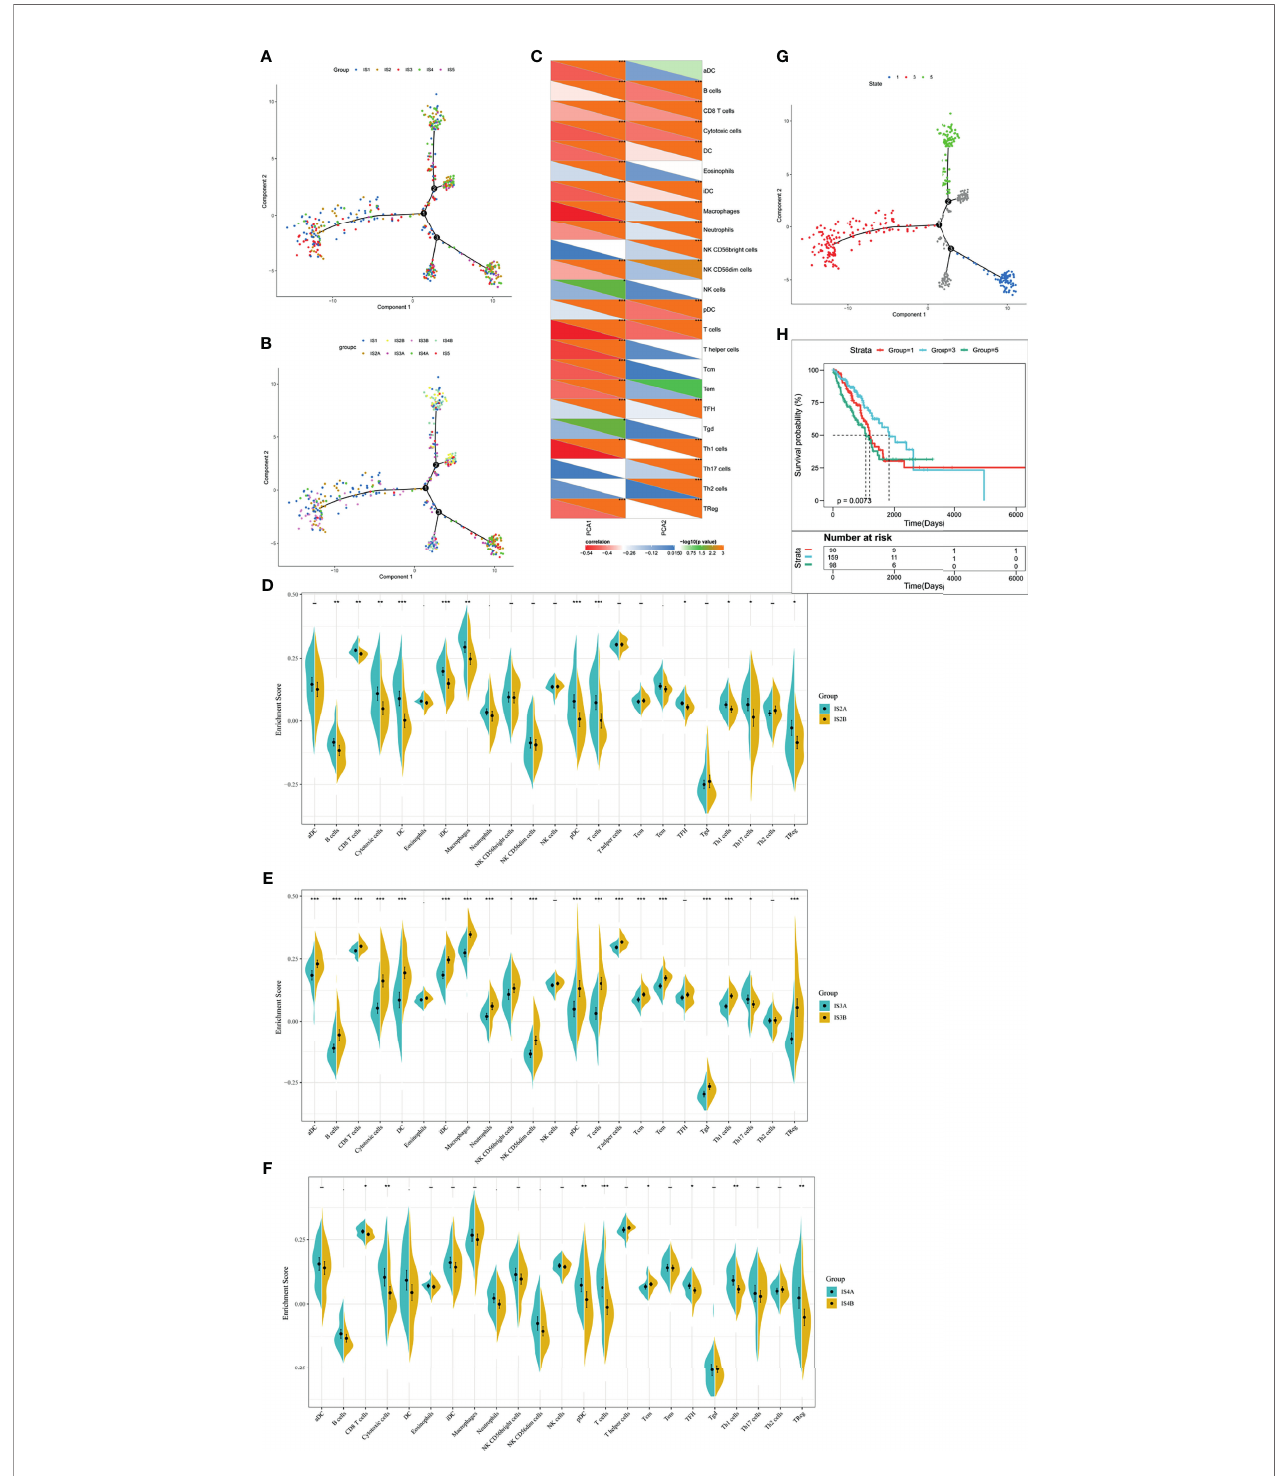
FIGURE 7 | The immune landscape of LUAD. (A) Dimensionality reduction analysis of LUAD patients. Each point stands for a patient with a certain IS. The horizontal axis represents PCA1 and the vertical axis represents PCA2. (B) Immune landscape of the subgroups of LUAD-related ISs. (C) The correlation heatmap of PCA1 and PCA2 with 23 immune cell signatures. (D – F) Differential enrichment scores of twenty-three immune cell signatures in the IS3 (D) , IS4 (E) , and IS5 (F) . *p < 0.05, ** p < 0.01, *** p < 0.001. (G) Immune landscape of samples from three extreme bivariate distributional positions (groups 1, 4, and 5). (H) Kaplan – Meier curves of LUAD patients in three extreme bivariate distributional